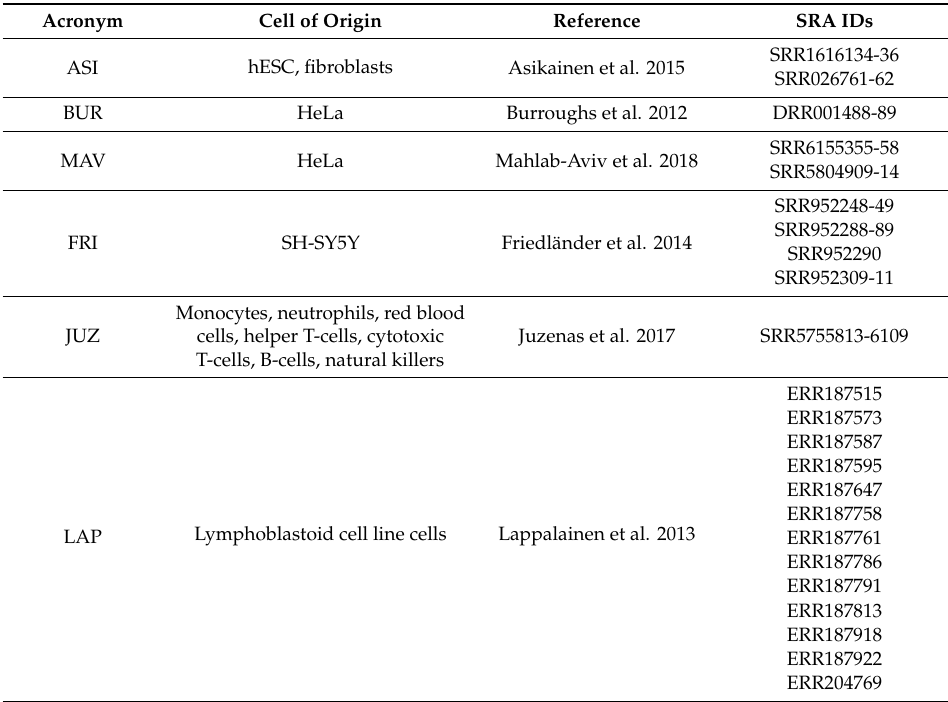
Table 1. Small RNA-seq datasets considered in this